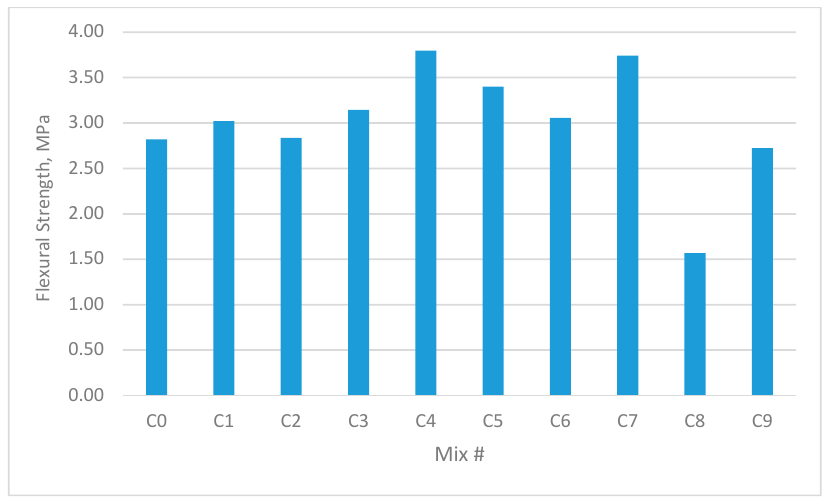
Figure 10. Flexural strength of concrete beams with W/B ratio 0.3.